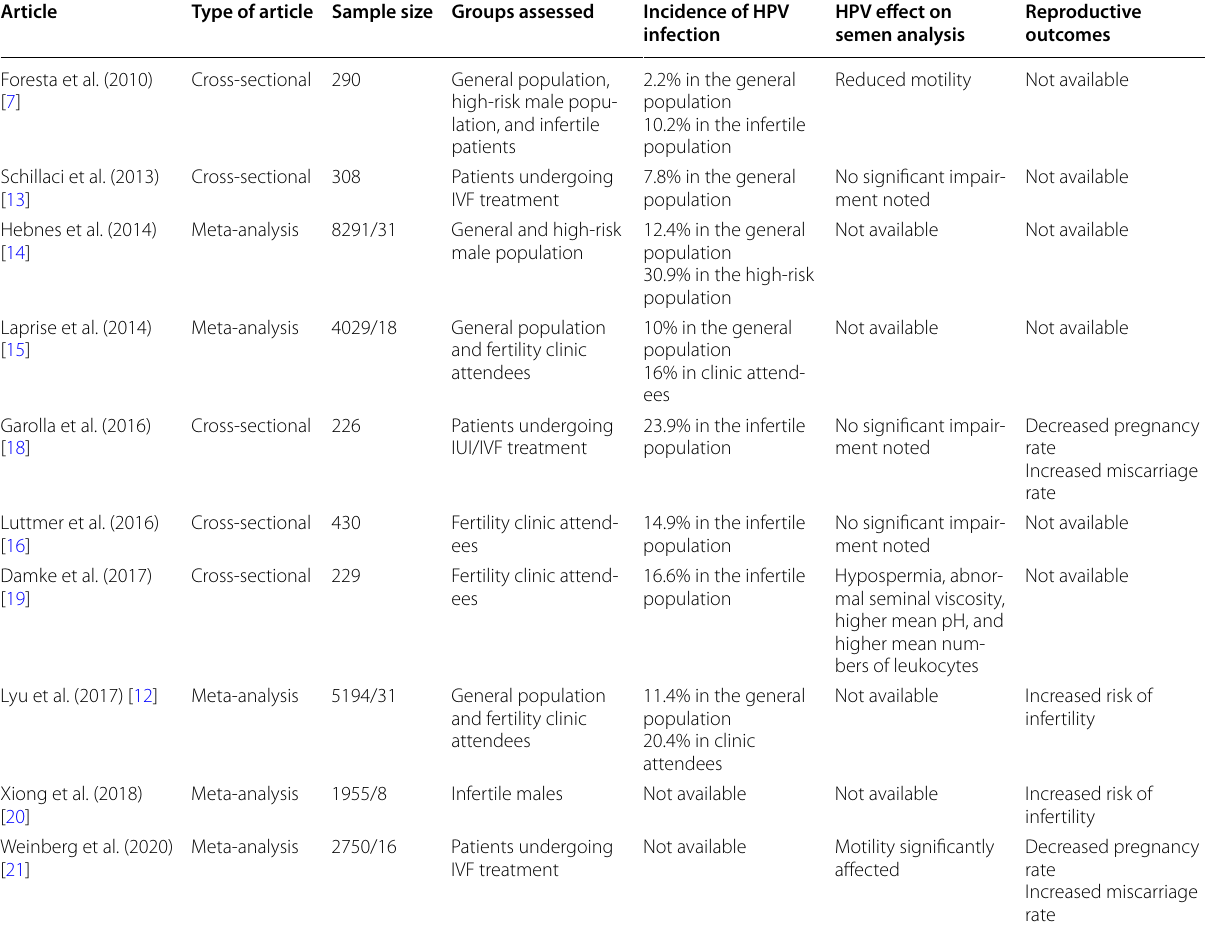
Table 1 Summary of the articles included in the